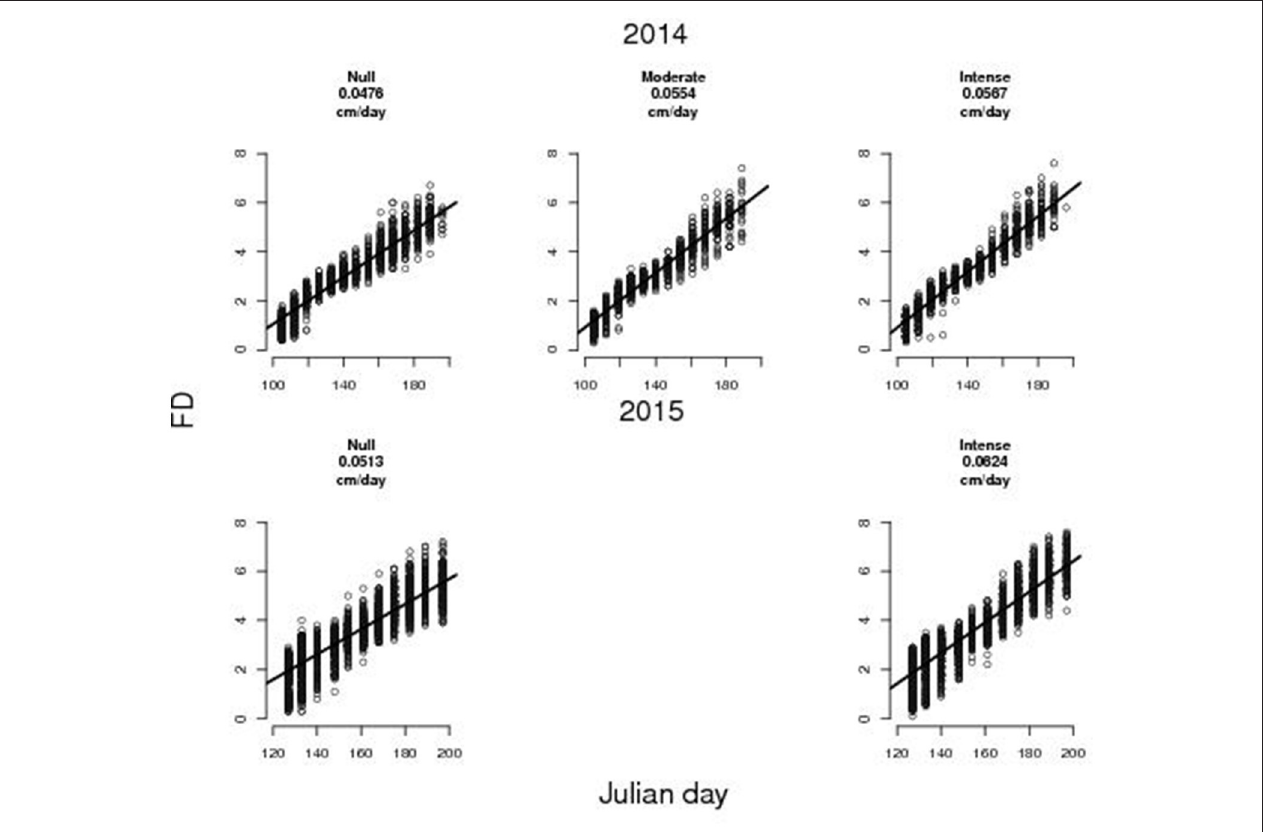
FIGURE 1 | Observed fruit diameters (FD) at different sampling dates relevant to trees subject to different thinning treatments (i.e., null, moderate, and intense thinning intensity, that correspond to leaving almost 25, 6, and 3 fruits per meter of fruit bearing shoot). The black line represents the linear regression of the FD (cm) vs. Julian Day. Estimated average fruit growth rate in diameter is reported in each